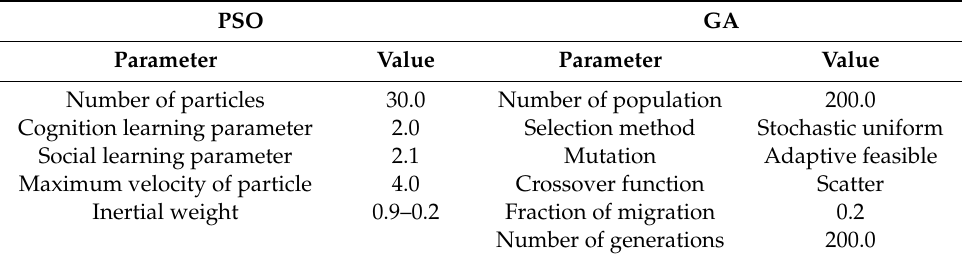
Table 6. Particle swarm optimization (PSO) and genetic algorithm (GA) parameters used to set the optimization framework for SMR and C3MR processes.